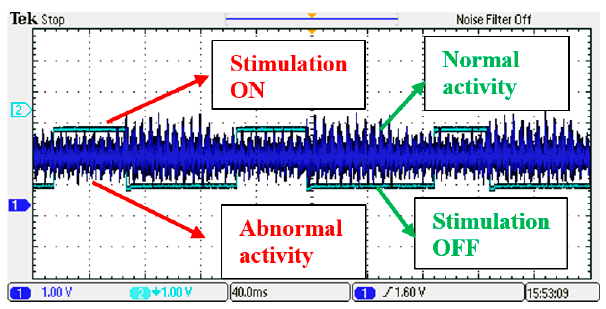
Figure 17. Stimulation control signal of the CLOS device.